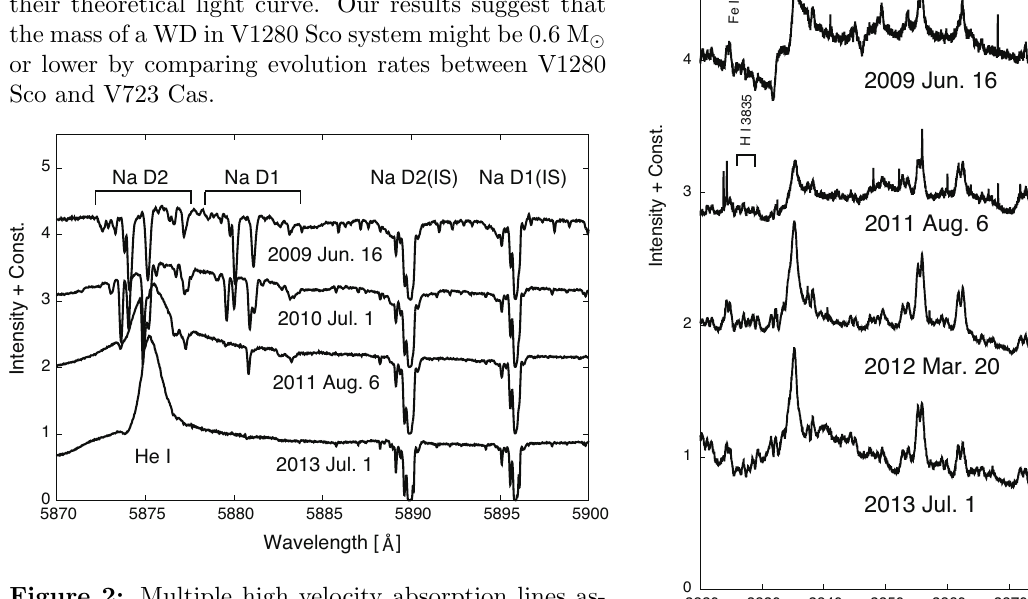
Figure 2: Multiple high velocity absorption lines as- sociated with Na i D1 and D2.